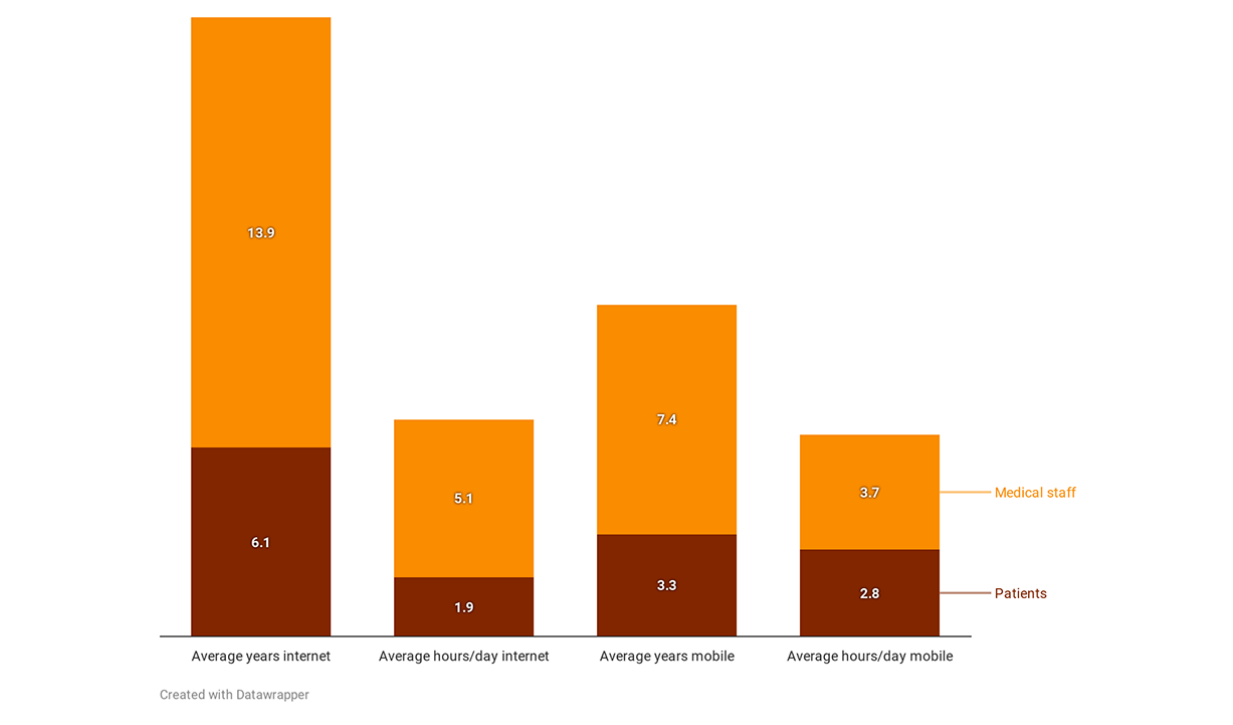
Figure 1. Internet and mobile experience for the two participant